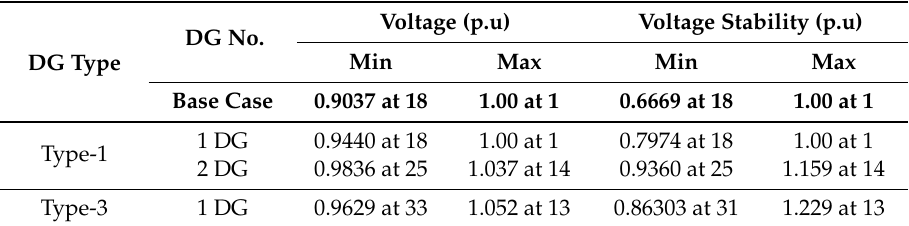
Table 6. The voltage profile and voltage stability of the system for 2nd objective